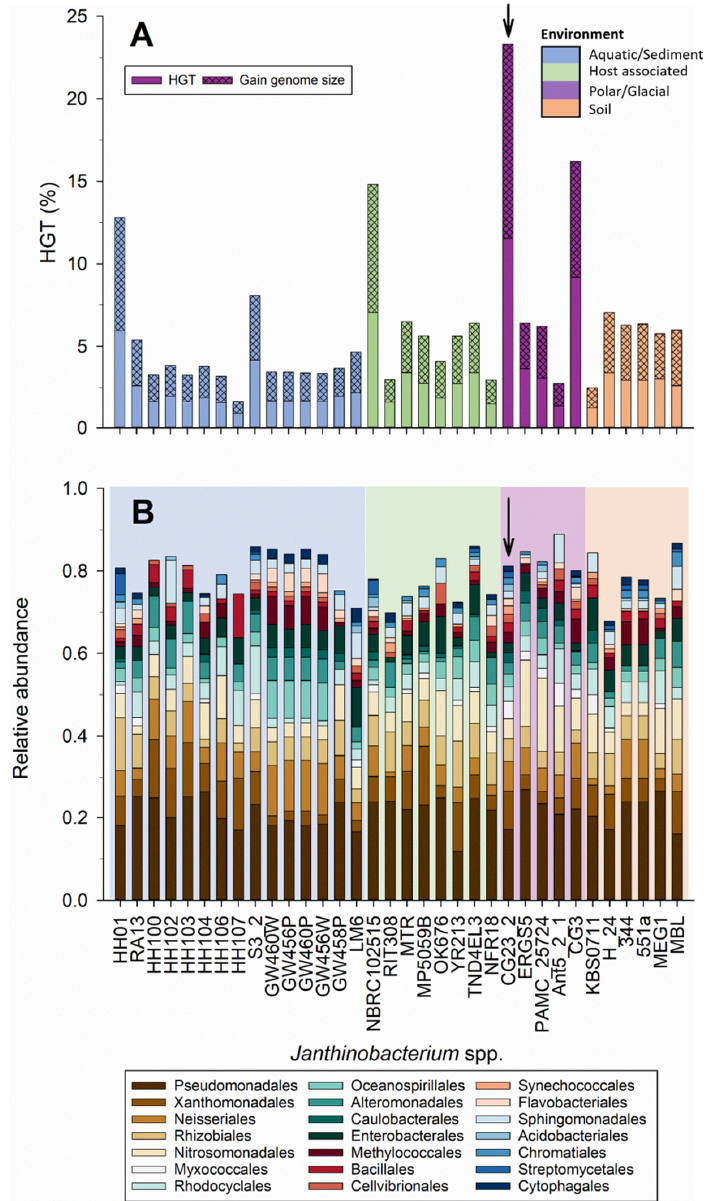
Figure 7. ( A ) Percentage of putatively horizontally transferred genes identified for the 34 Janthinobacterium spp. ( B ) Relative abundance of predicted horizontal gene transfer (HGT) donors based on the 20 most abundant orders identified in Janthinobacterium sp. CG23_2. Data are presented at the order level. Shaded colors indicate the five environments. Arrows mark Janthinobacterium sp. CG23_2. Of the 741 putatively identified HGT events in Janthinobacterium sp. CG23_2, 292 or 4.5% of the